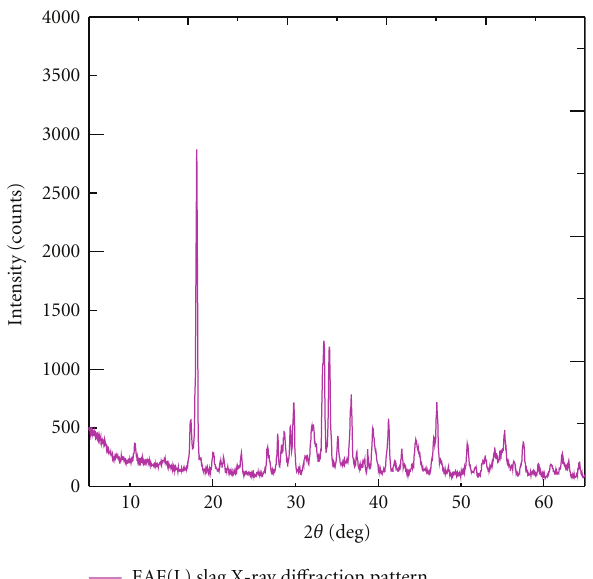
Figure 8: X-ray di ff raction patterns for EAF(L) slag.